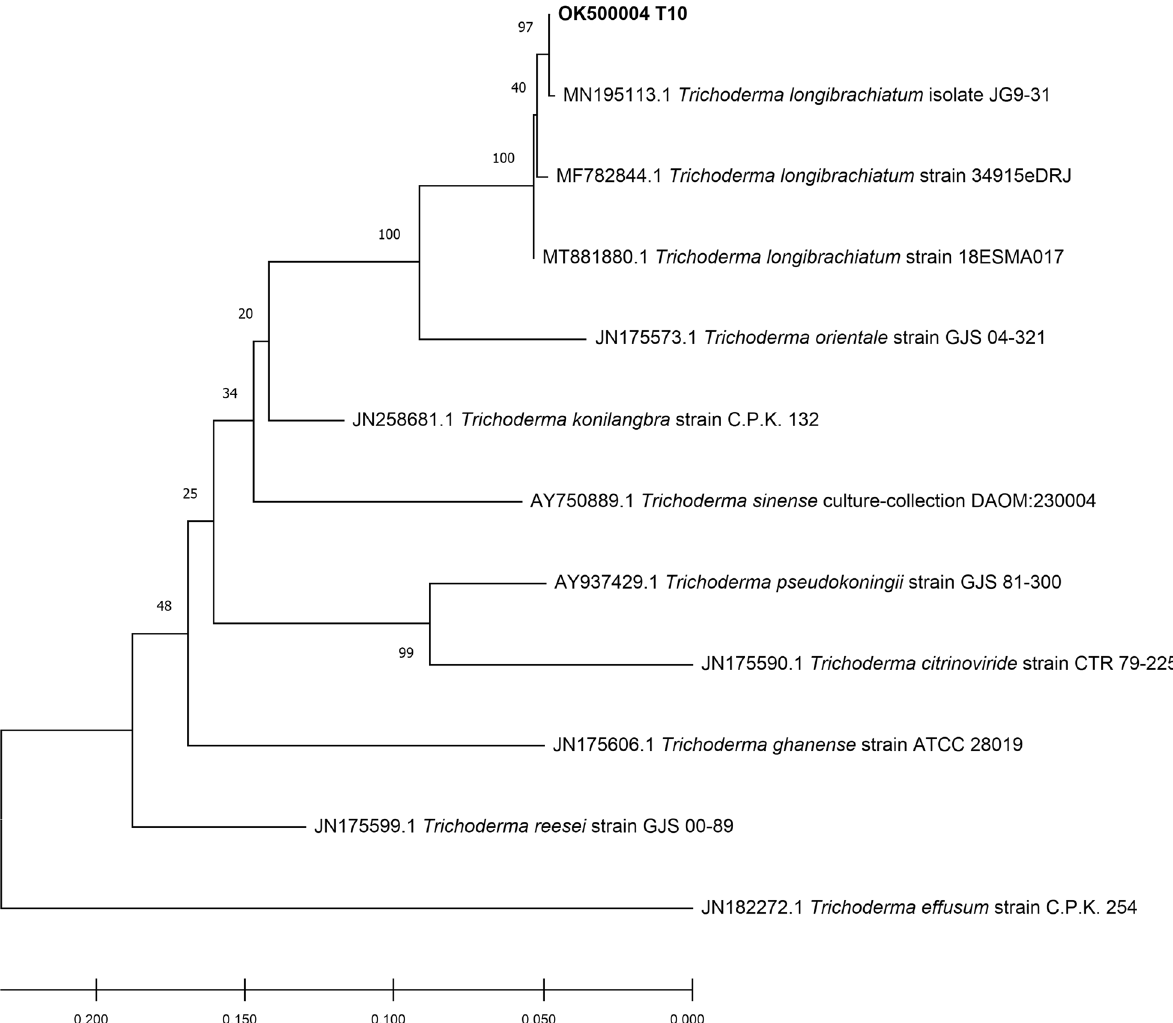
Fig. 2 Phylogenetic tree of the Trichoderma spp. inferred by Neighbor Joining method of TEF1-α sequence. The bootstrap values from 1000 replication are indicated on the branches